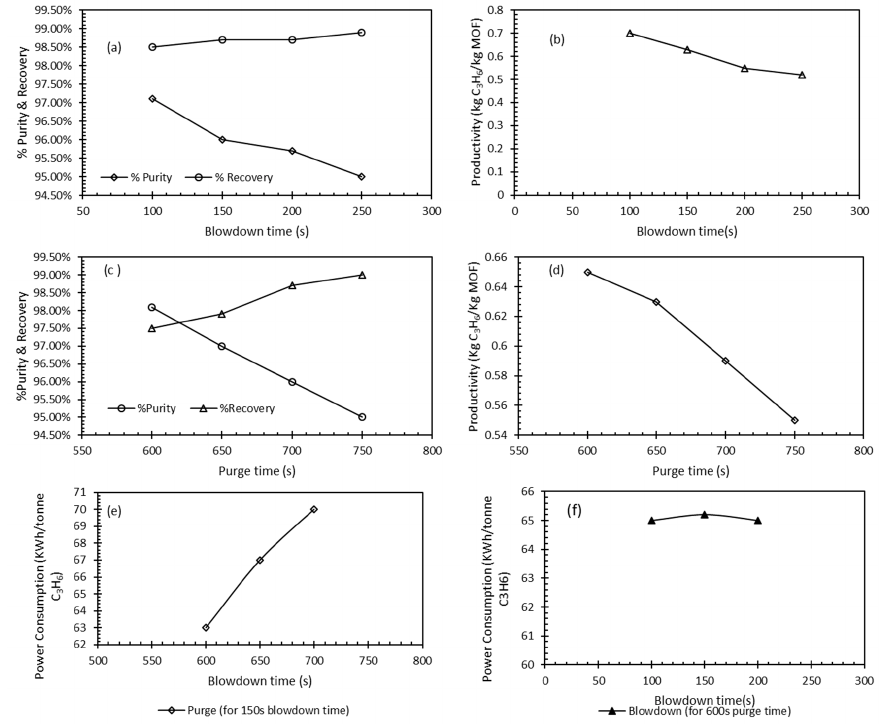
Figure 10. Key VSA performance indicators for C 3 H 4 /C 3 H 6 separation: ( a ) impact of blowdown time on purity and recovery of C 3 H 6 ; ( b ) productivity with respect to blowdown time for C 3 H 6 ; ( c ) purity and recovery as a function of purge time; ( d ) productivity of C 3 H 6 with change in purge time; ( e ) power consumption with respect to different blowdown times and purge of 150 s; ( f ) power consumption as a function of blowdown time for 600 s purge time.